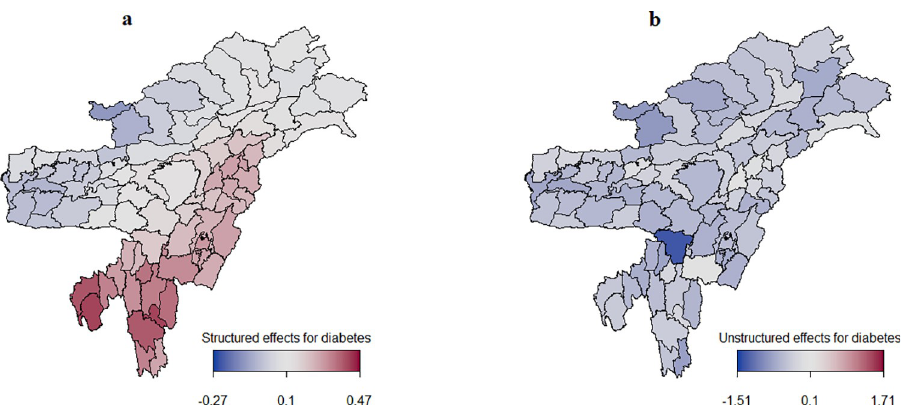
Fig 5. Estimated posterior means of the structured spatial effects (left) and the unstructured spatial effects (right) for the log-odds of diabetes. https://doi.org/10.1371/journal.pone.0262560.g005 PLOS ONE | https://doi.org/10.1371/journal.pone.0262560 January 13,